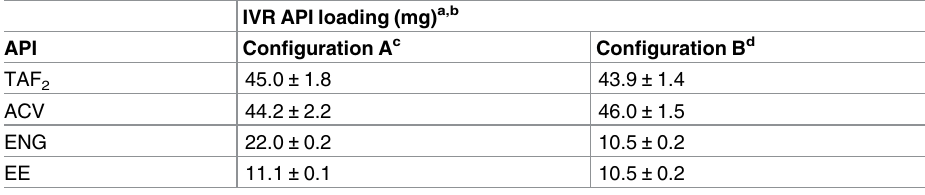
Table 1. Drug loading in pod-IVRs used in pigtailed macaque